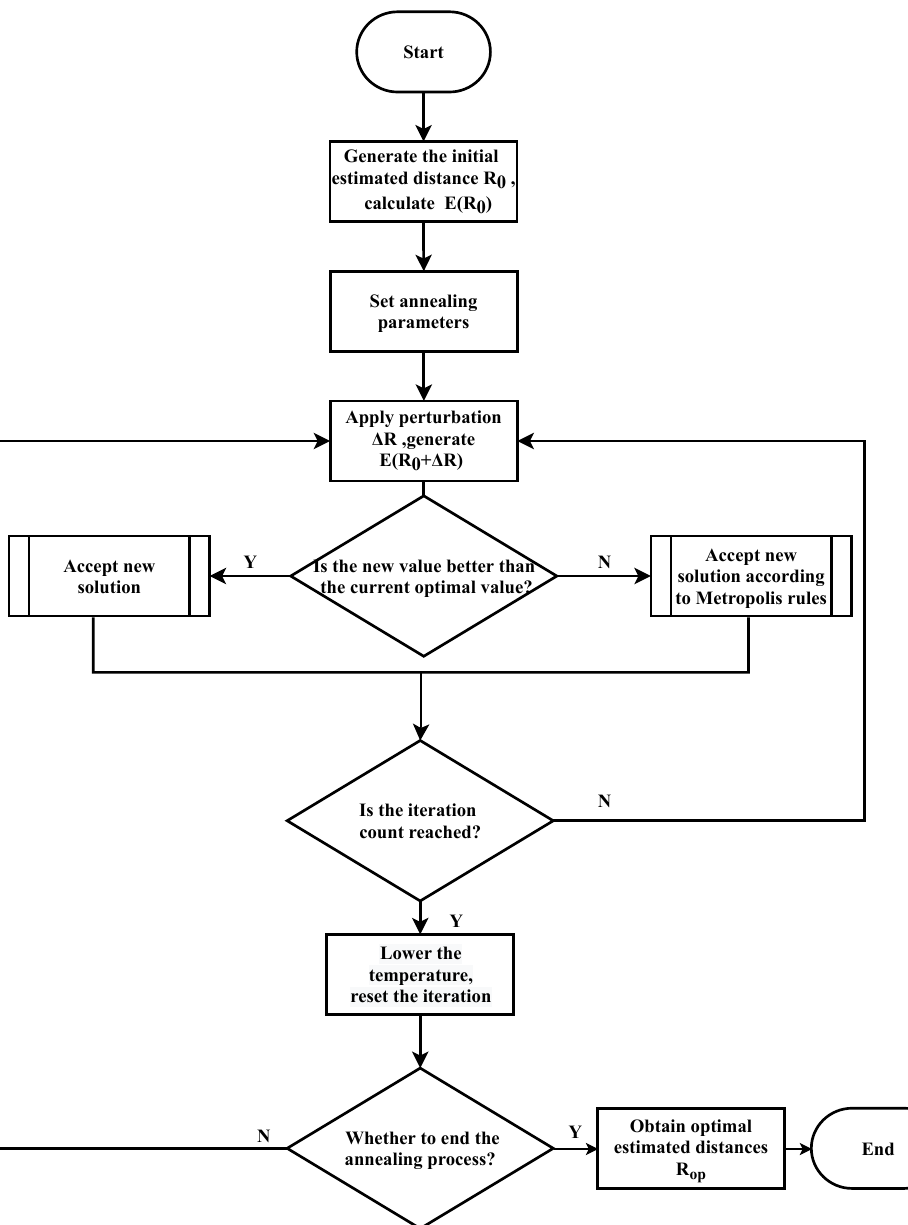
Figure 3. The flowchart of the simulated annealing algorithm for the optimization problem of the target–instrument distance